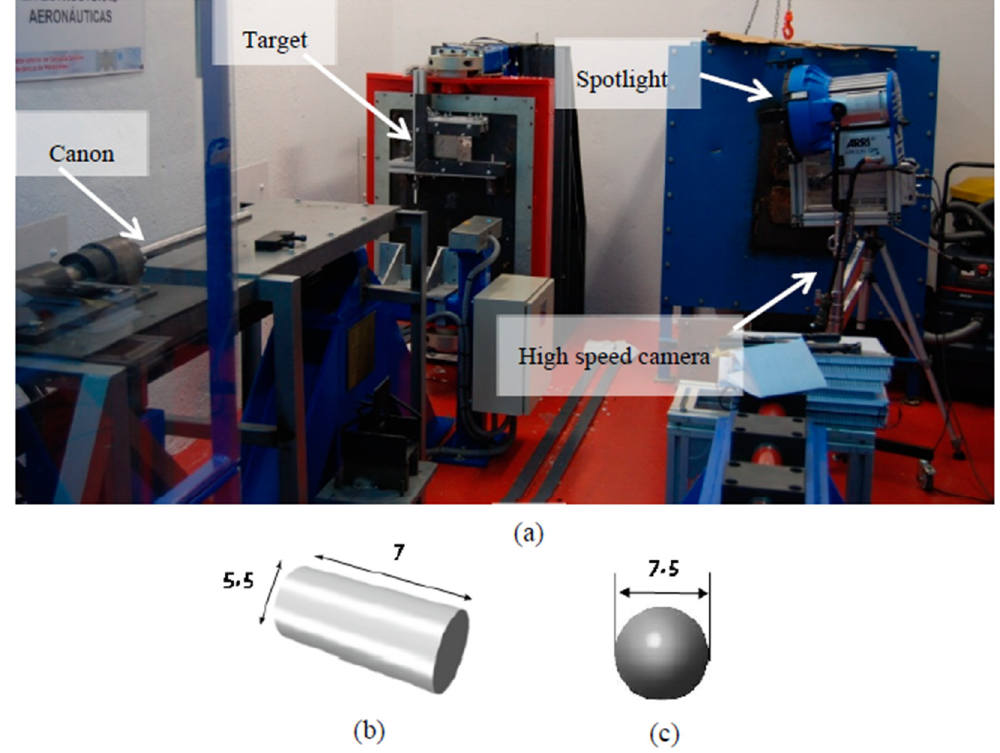
Figure 8. ( a ) Scheme of experimental set up used for perforation test. Geometry and dimensions (mm) of the projectiles used in the perforation test: ( b ) blunt projectile; ( c ) spherical projectile. The specimens are clamped in the front and back sides of the outline of the plate; sliding effects are not observed during the test. A Photron FastCam SA-Z digital high-speed camera (Photron USA, Inc., San Diego, USA) is used to measure the impact and residual velocities when the projectiles impact and perforate the target, Figure 9. The selected frame rate (28,000 frames per second, fps) and the resolution 1024 × 744 pixels are chosen based on early testing, allowing a proper focus on the images. The high-speed camera is placed perpendicularly to the impact allowing for capturing both the entrance and the exit of the projectile from the same